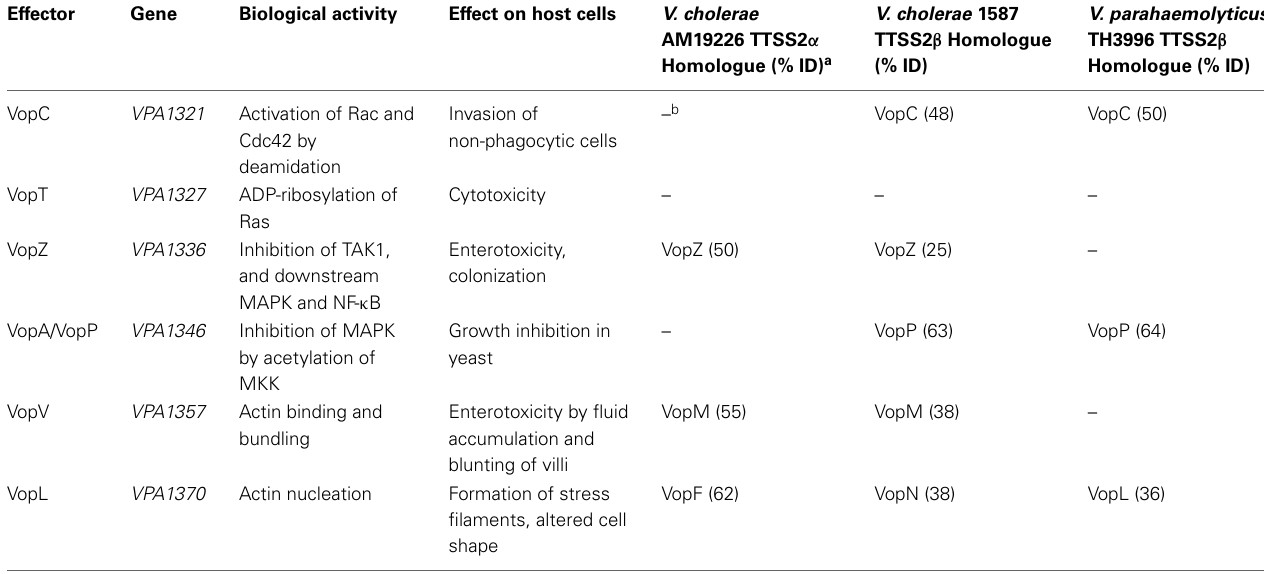
Table 1 | Characterized V. parahaemolyticus TTSS2